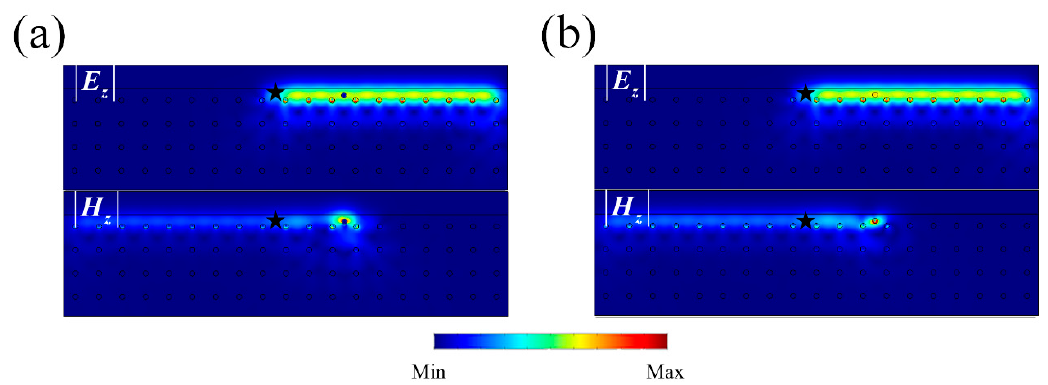
Figure 4. Field distribution with mixed impurities. We mixed impurities with character Hamiltonians ˆ H = iI and ˆ H z = σ z with ˆ H = i σ x . Field distribution with impurities ( a ) be seen that by exchanging TE and TM modes, ˆ H iI and ˆ H z will induce backscattering.